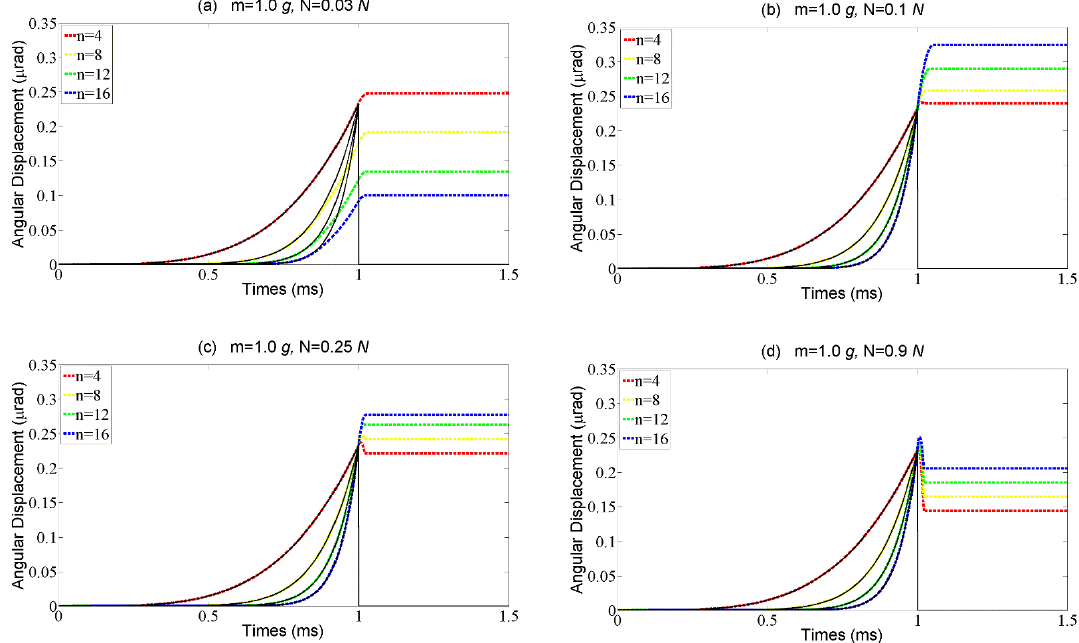
Figure 8. The rotor angular displacement vs different driving signals described by the base numbers with four external loads, ( a ) N = 0.03 g; ( b ) N = 0.1 g; ( c ) N = 0.25 g; ( d ) N = 0.9 g.